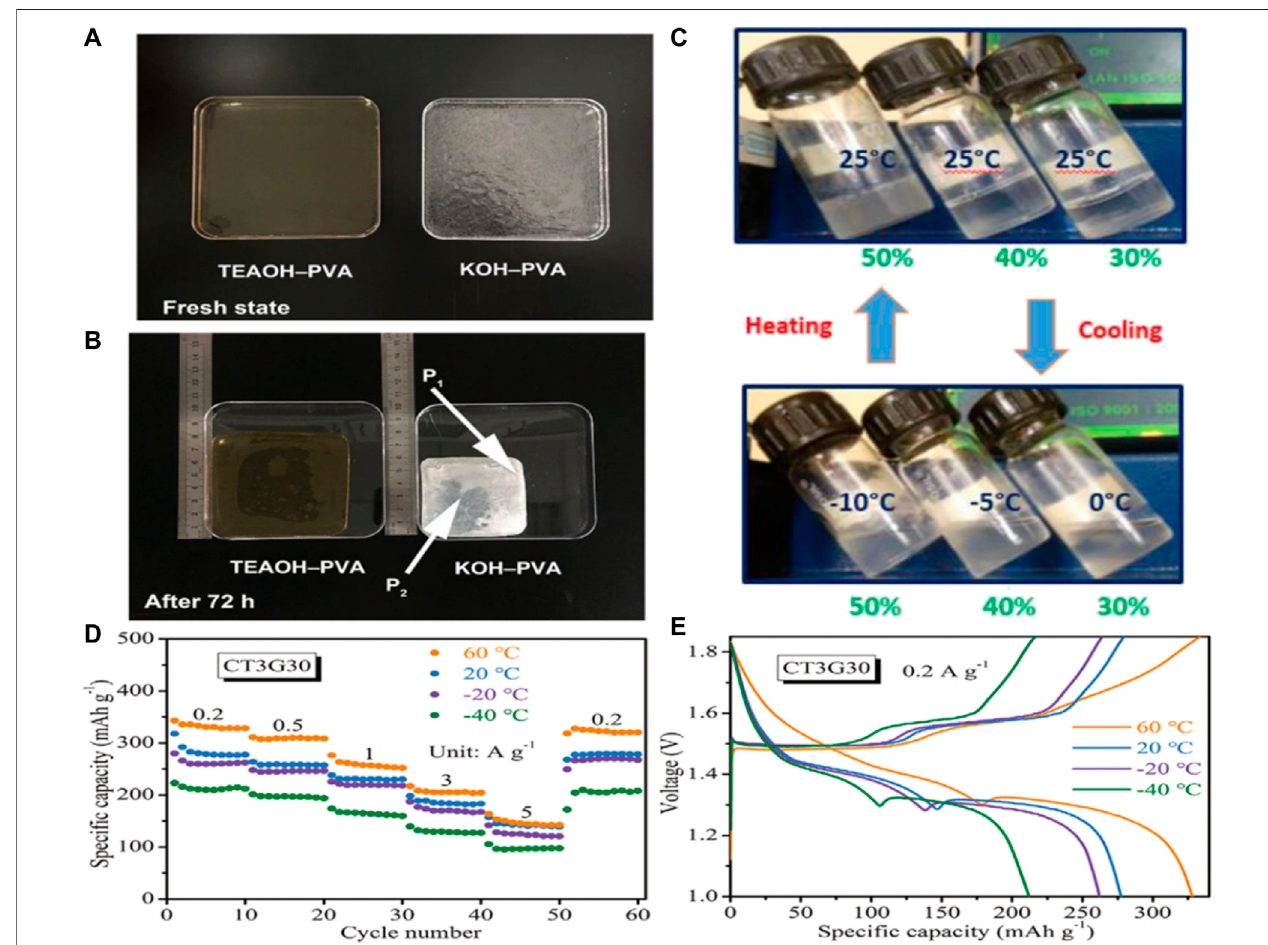
FIGURE 7 | Optical photos of (A) freshly prepared electrolytes and (B) electrolytes stored in the open ambient environment (RH = 30%, 20 ° C) for 72 h.Copyright 2019 Nano Energy. (C) Photographs of PHEs with polymer concentration ranging from 30% (w/w) to 50% (w/w) at varied temperatures, showing the thermoreversible gelation behavior. Copyright 2017 Angewandte Chemie International Edition. (D) Rate performance, (E) GCD curves at 0.2 A/g. Copyright 2021 Wiley-VCH GmbH.